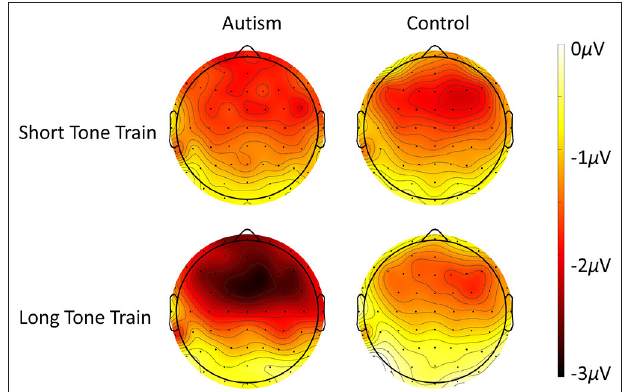
FIGURE 4 | Scalp topography of the MMN response to the deviant after the short tone train (top row) and the long tone train (bottom row) for autism (left column) and neurotypical controls (right column). Note that negative (darker color) reveals site of highest deviant response, as evident especially over frontal areas to the long tone train